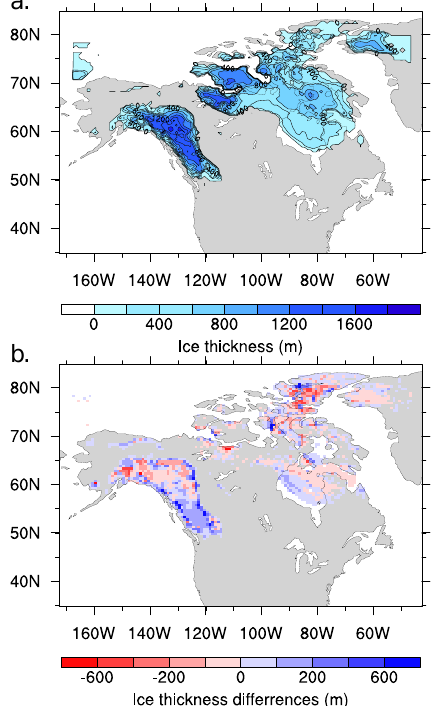
Figure 11. Ice field during inception at 115ka for a simulation using one of the parameter vectors that generates best fits to the calibra- tion constraints (nn9894). (a) Ice thickness with SG turned on. (b) Ice thickness differences between simulations with the SG model turned on and off. Zero differences are presented in the same colour as the